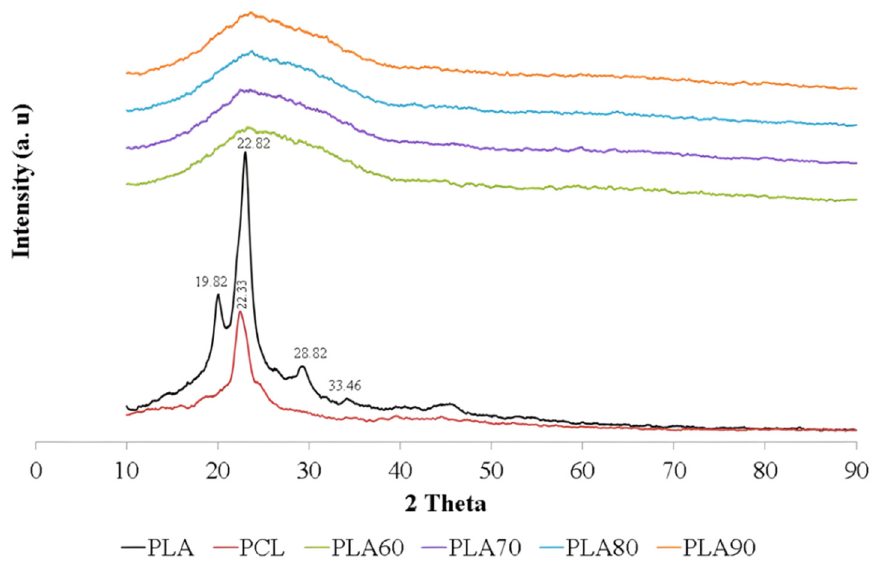
Figure 3. X ‐ ray diffraction (XRD) patterns of samples. Figure 3. X-ray diffraction (XRD) patterns of